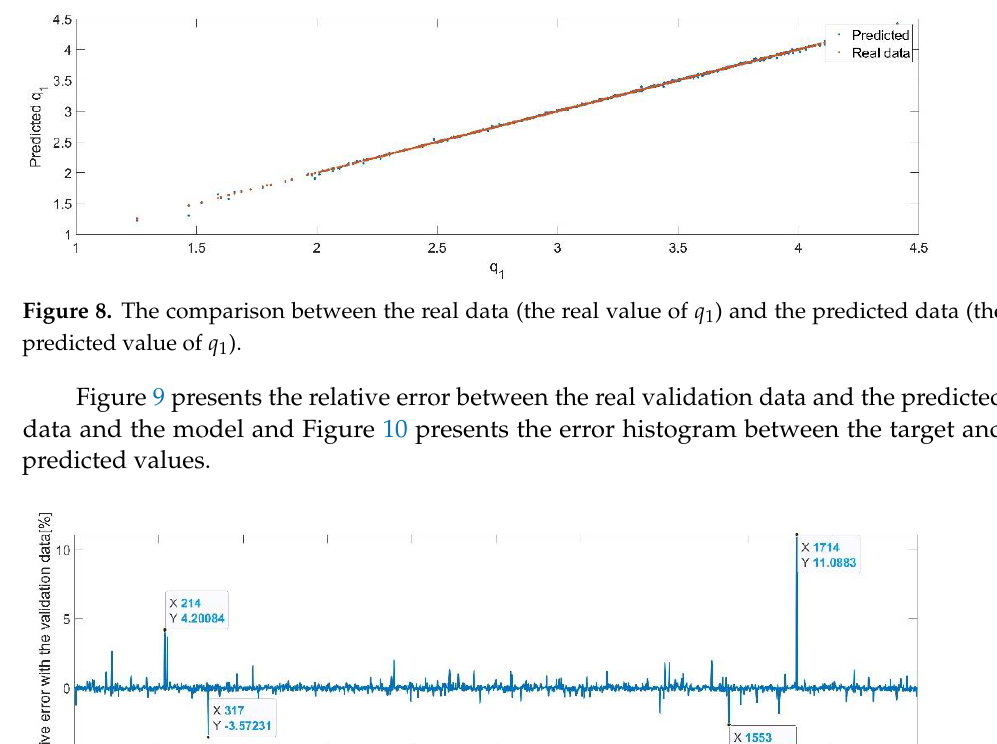
Figure 7. Convergence of the neural network for the first generalized coordinate 𝑞 1 (log scale).